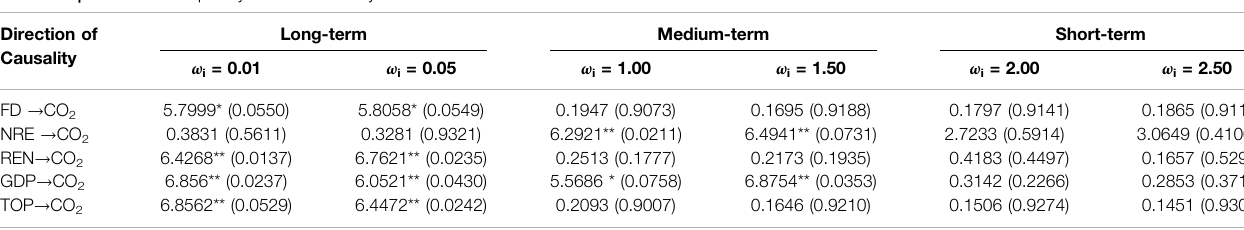
TABLE 6 | Results of Frequency domain causality